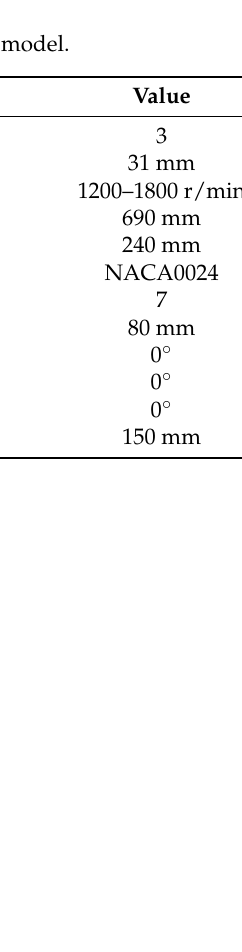
Figure 5. Nacelle vibrations at different wind speeds.